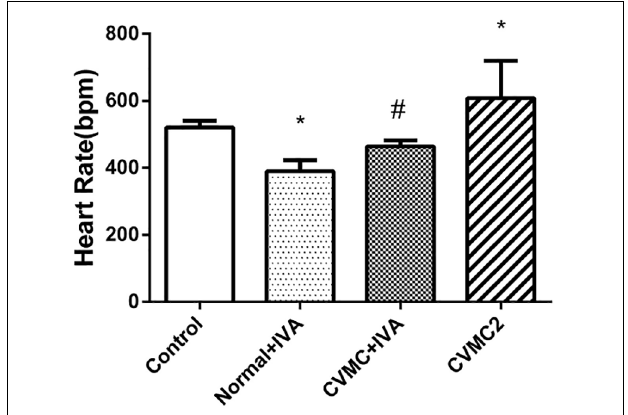
FIGURE 1 | The heart rate in Normal control 2 group ( n = 8), Normal + IVA group ( n = 8), CVMC + IVA group ( n = 8), and CVMC2 group ( n = 8) on the 72nd day. Treatment with ivabradine (IVA) significantly reduced heart rate in CVMC+IVA group versus CVMC2 group. ∗ P < 0.05 vs. Control (Normal control 2 group), # P < 0.05 vs.